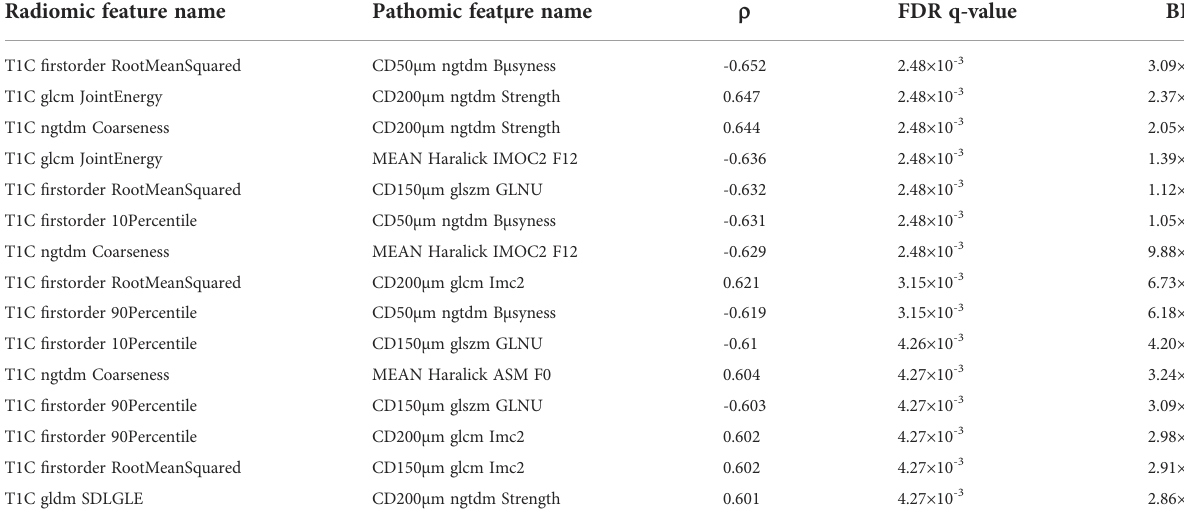
TABLE 3 Summary of the highest-correlated ( r >0.6) radiomic-pathomic features, with radiomic features extracted from